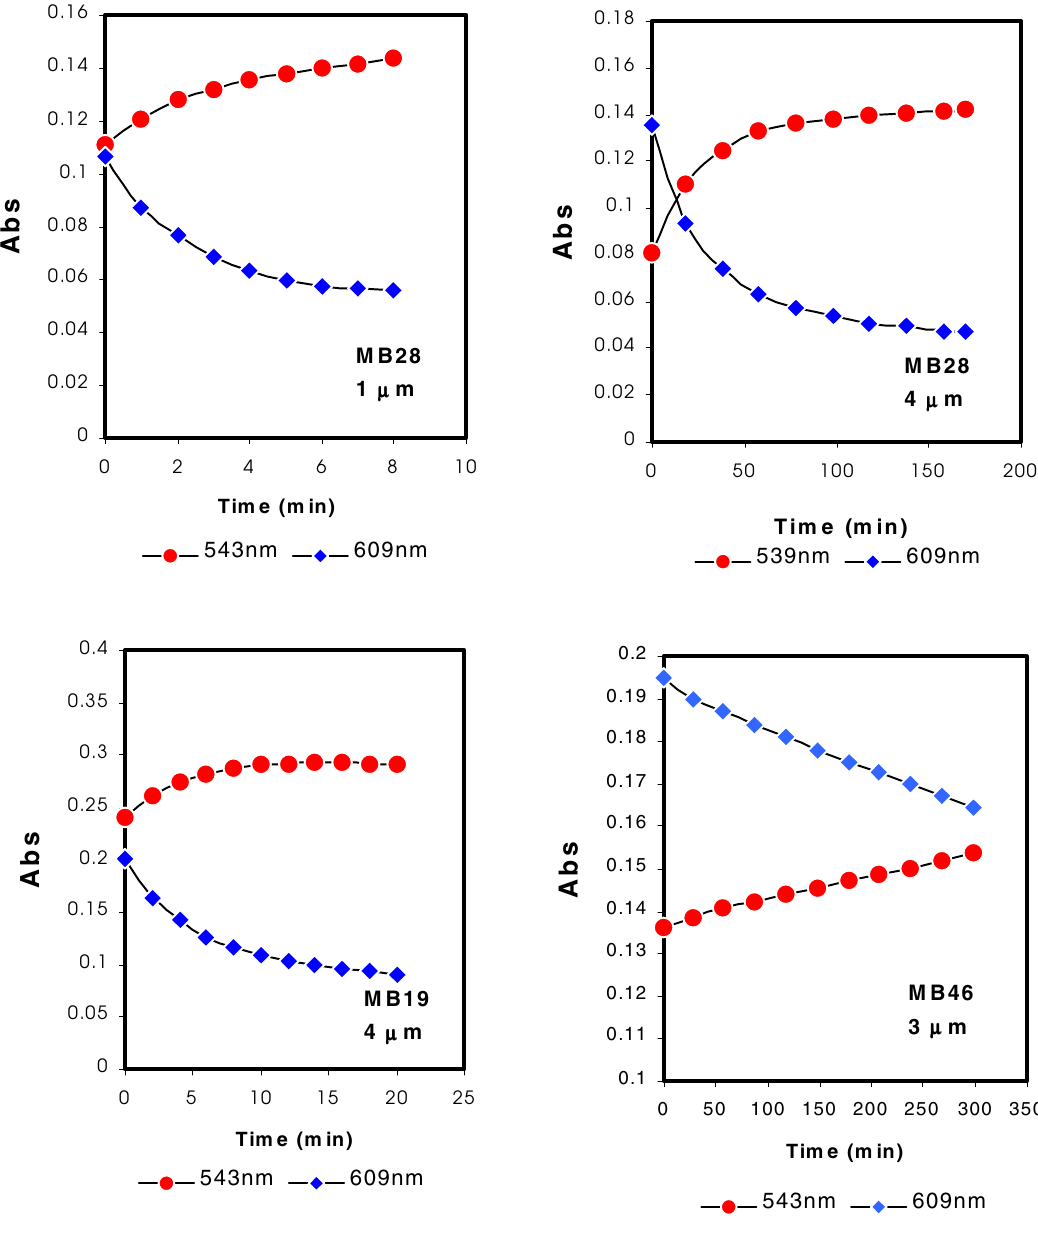
Figure 4. The response of various copolymer optode films with different thickness measured at two wavelengths after exposure to 6 M of